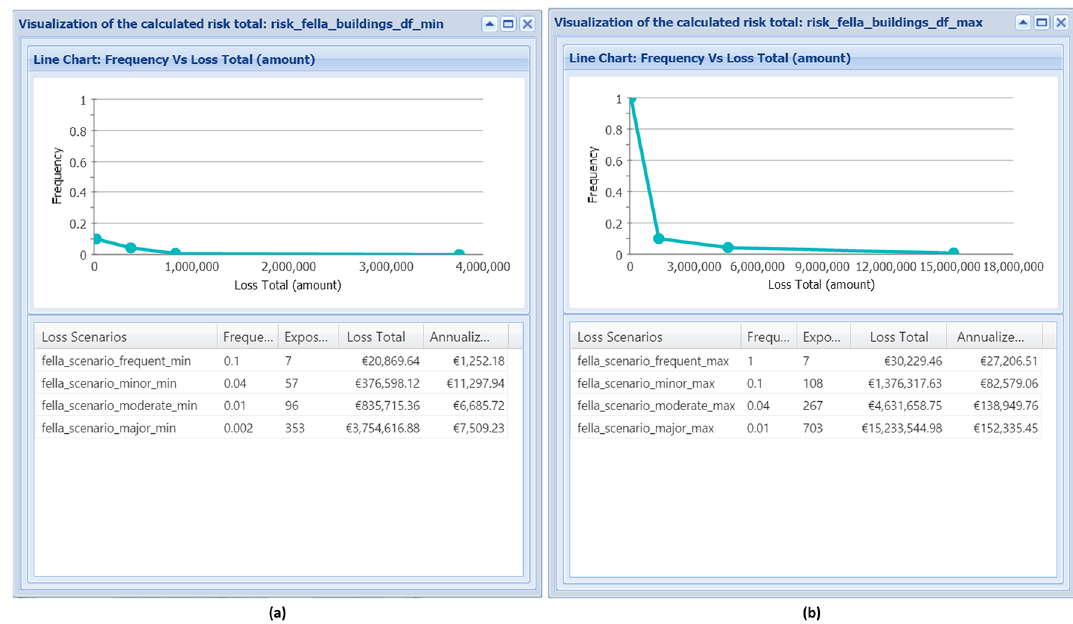
Figure 14. (a) Visualization of the debris flow risk curve (minimum). (b) Visualization of the debris flow risk curve